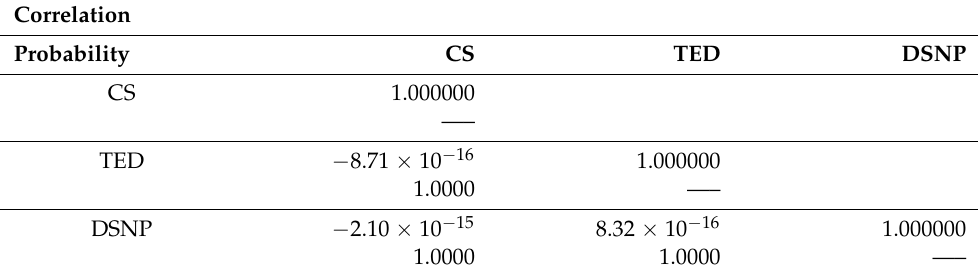
Table 13. Correlation after